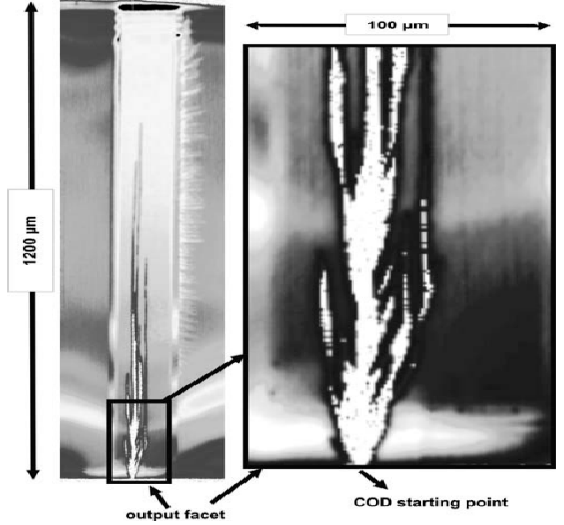
Figure 11. µ-PL mapping of a laser after COMD with a magnification of the output facet (white=low (white = low PL intensity and black = high PL intensity). Reprinted with permission from ref. [69] PL intensity and black = high PL intensity) [69]. Reprinted with permission from ref. [69] © AIP © AIP Publishing. Copyright 2006 Applied Physics Publishing. Copyright 2006 Applied Physics Letters.